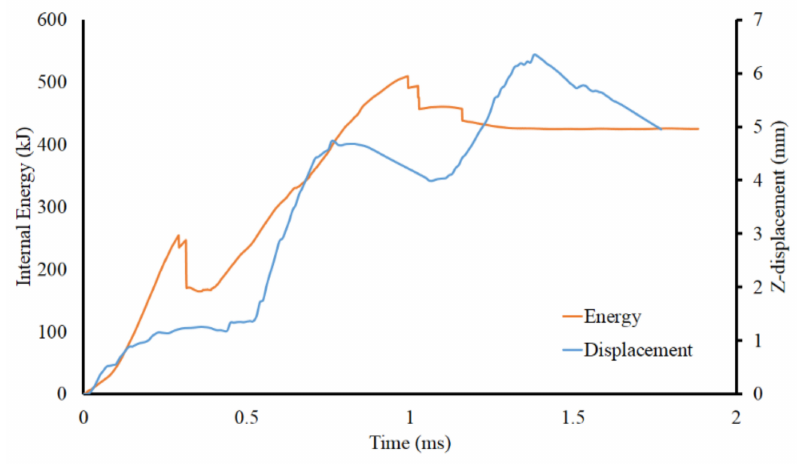
Figure 10. Energy absorption of baseline sandwich panel and displacement on battery jellyroll.